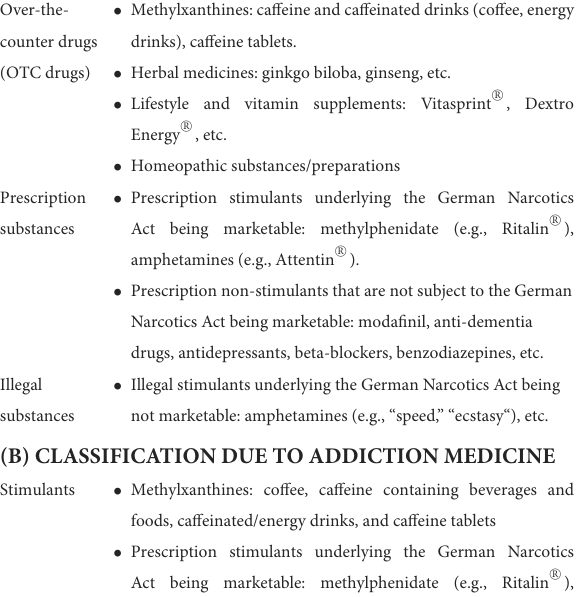
TABLE 1 Possible classifications of CE